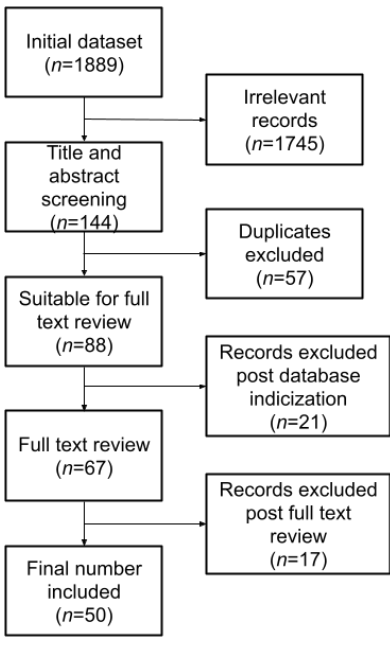
Figure 1. PRISMA diagram: flowchart showing screening and selection of relevant papers. For a description of the selection process, please refer to Section 2.1.